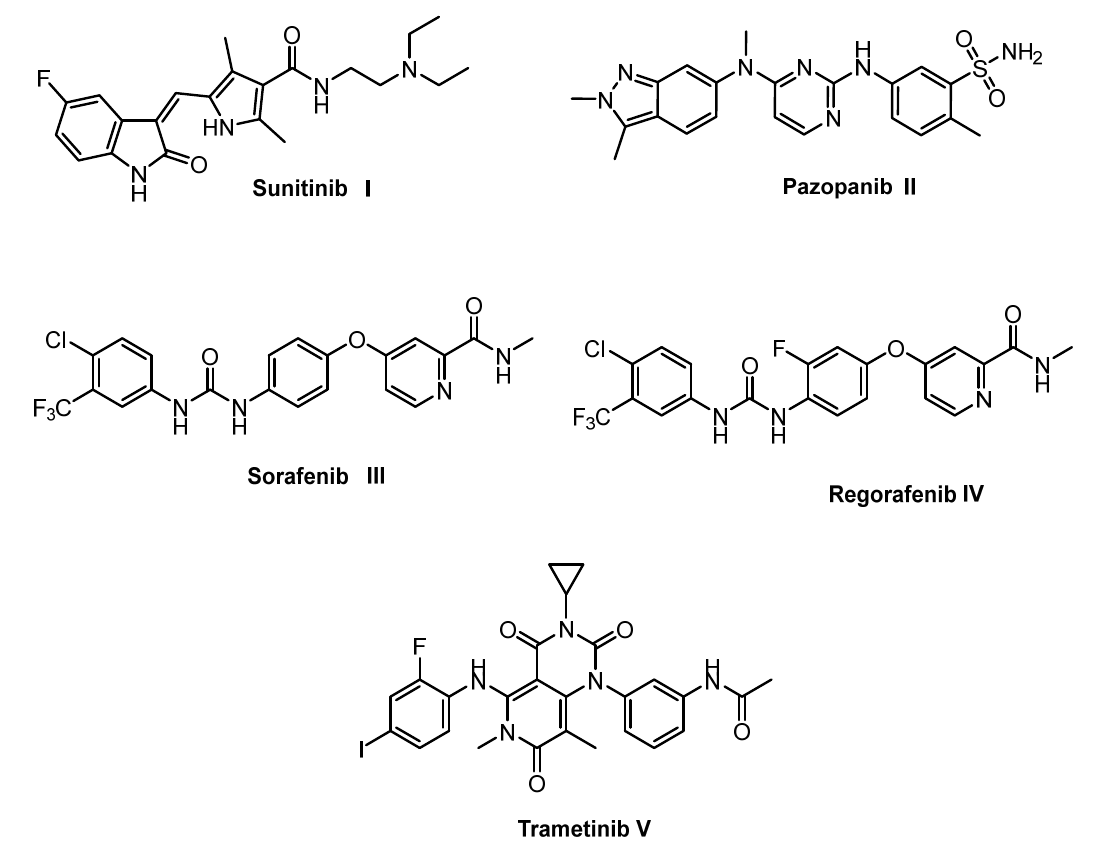
Figure 1. Some reported VEGFR